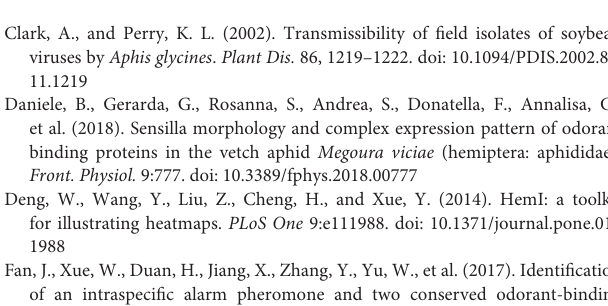
Supplementary Data 2 | Transcriptome data information. Supplementary Data 3 | Differential expression transcript list. Supplementary Data 4 | GlyOBP sequences. Supplementary Data 5 | GlyOBP FPKM